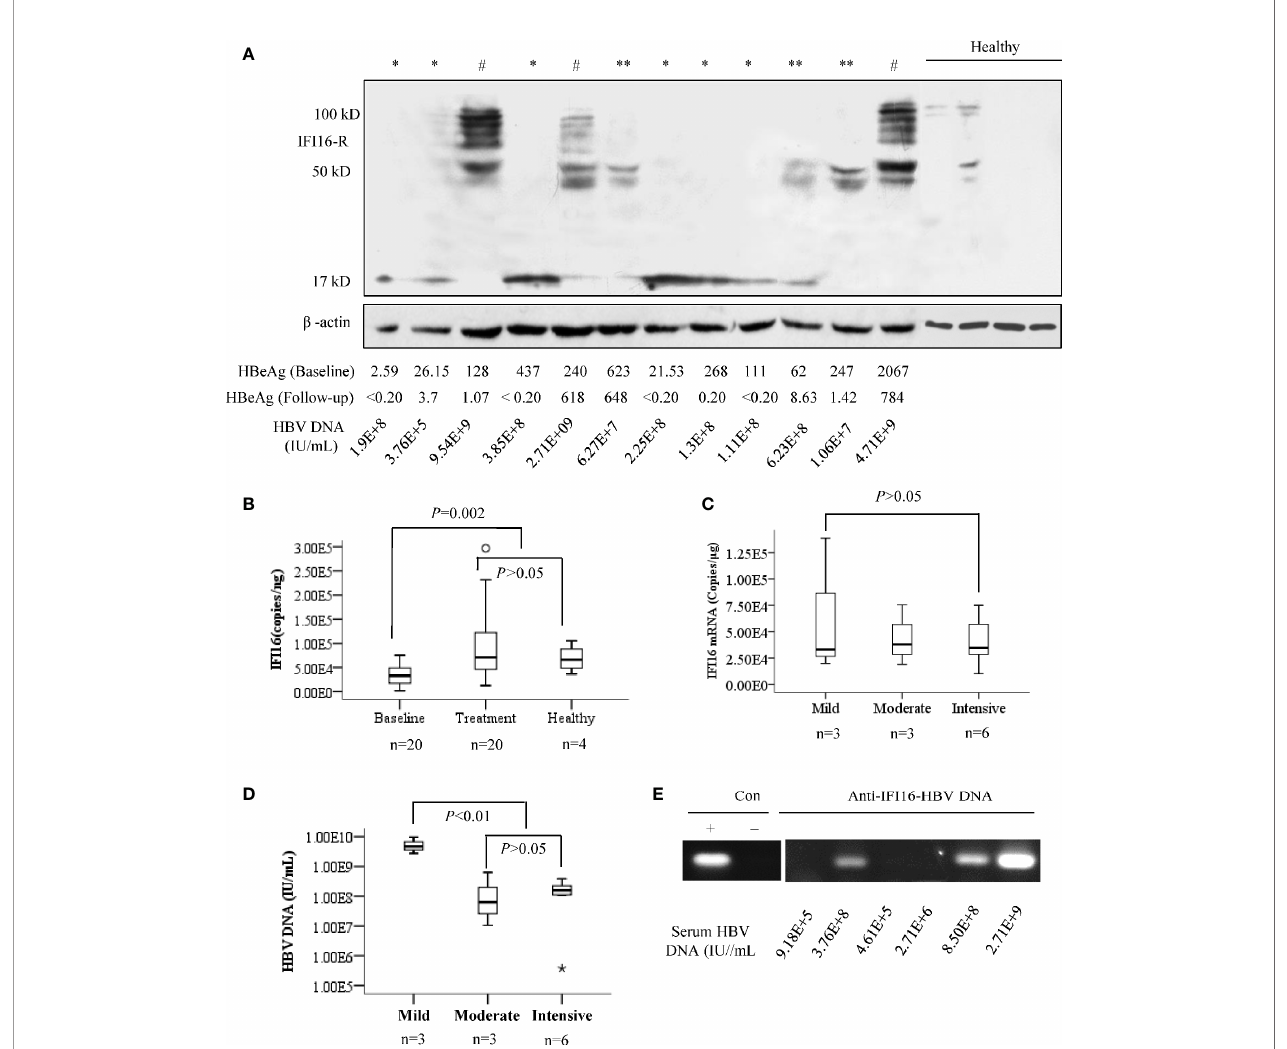
FIGURE 1 | IFI16 expression and degradation in the peripheral blood mononuclear cells (PBMCs) of chronic hepatitis B (CHB) patients. PBMCs from 12 patients with CHB and four healthy donors were included for analysis. Based on the fragment migration in the PAGE gel, IFI16 degradation in PBMCs was classi fi ed into three patterns, including mild degradation (#, full length IFI16 at 95-100 kDa with fragments at 40-90 kDa), moderate degradation (**, 40-50 kDa), and intensive degradation (*, ~17 kDa). b -actin was used as an internal control for Western blot (A) . Mann-Whitney U test evaluated differences in IFI16 mRNA levels of PBMCs of patients at baseline, after two weeks of Peg-IFN- a 2b treatment, and healthy donors (B) . Mann-Whitney U test evaluated differences in IFI16 mRNA of PBMCs with different IFI16 degradation (C) . Serum HBV DNA levels were classi fi ed into three groups according to the degree of IFI16 degradation. Mann-Whitney U test was used to evaluate differences in HBV DNA levels among the groups (D) . ChIP assay was used for analyzing the interaction between IFI16 and HBV DNA in PBMCs of the baseline patients with CHB. The obtained DNA was subjected to PCR analysis of HBV DNA (E)